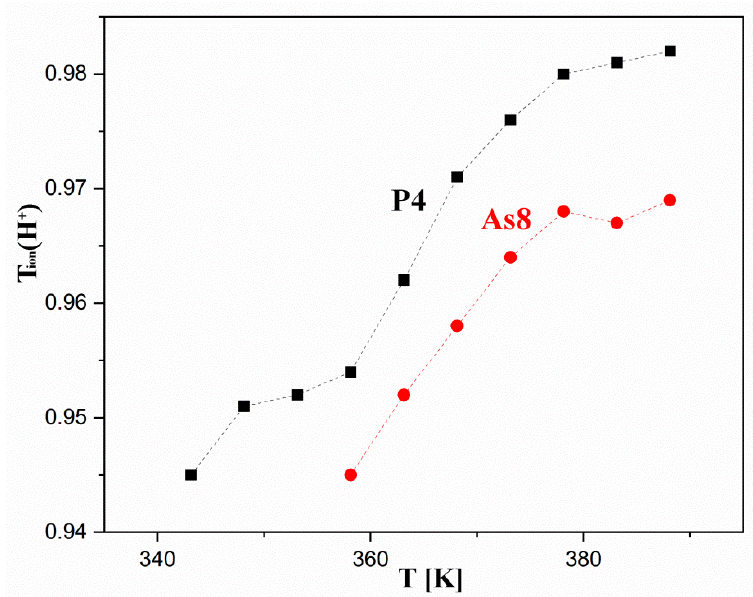
Figure 13. Values of protonic transference numbers determined for P4-(56% Gm + 44% HUP) in w% and As8-(18% Gm + 82% HUAs) composites as a function of the materials temperature.